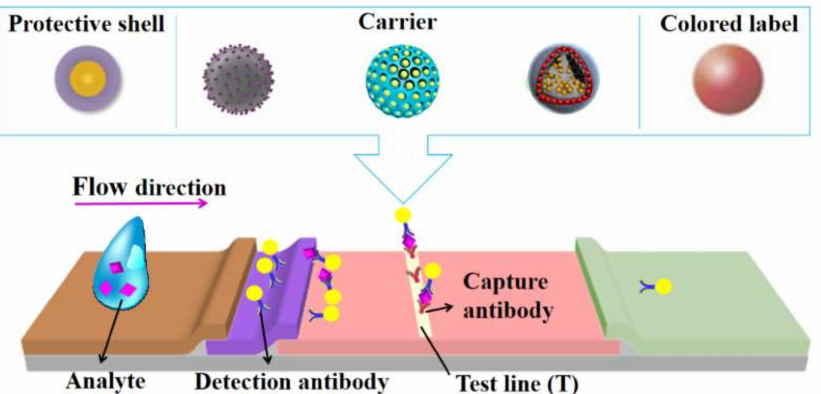
Figure 1. Schematic illustration of a silica-nanomaterial-assisted lateral flow assay (LFA). In LFAs, silica nanomaterials usually work as a protective shell to stabilize label materials, a carrier to enrich label materials for signal amplification or the colored label itself. Reprinted with permission from References